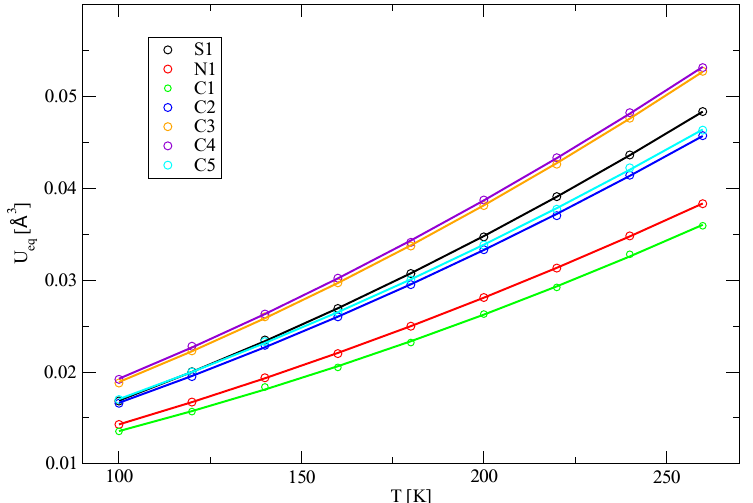
Figure 6. Temperature-dependent development of the equivalent isotropic displacement parameters U eq . The lines were obtained by quadratic fits, respectively. U eq = 1